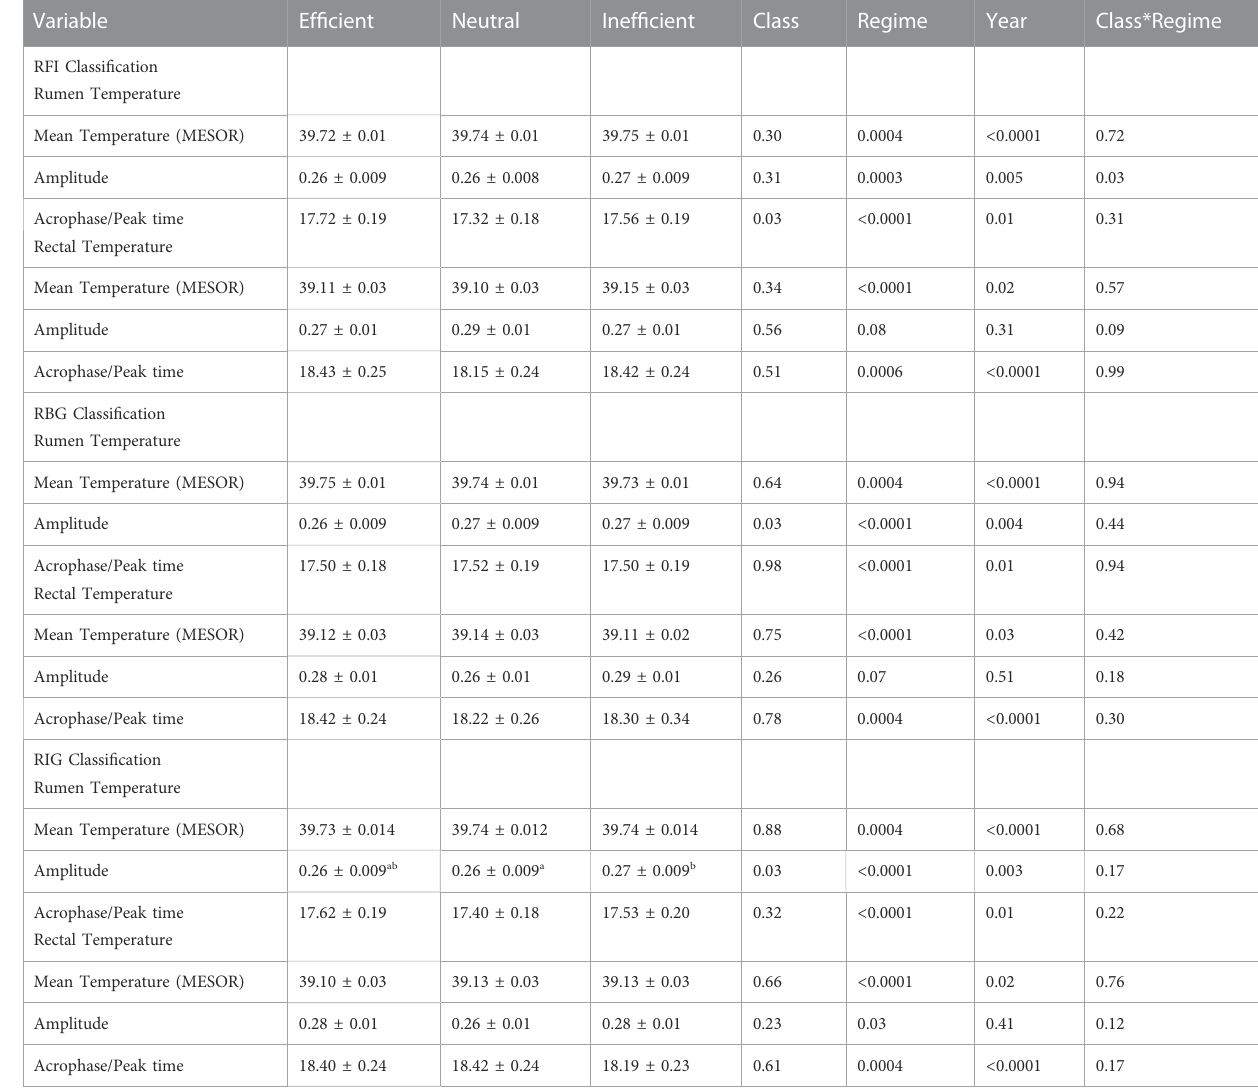
TABLE3Production ef fi ciency-basedproductionef fi ciency-basedclassi fi cation(LSmeans)andcircadian parameters forrumenandrectaltemperatureparameters calculated within the two regimes.